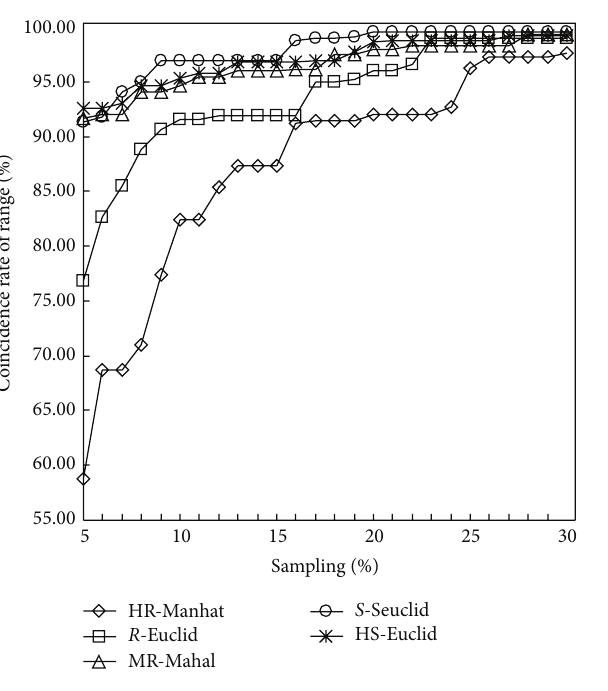
Figure 2: The coincidence rate of the range (CR) of subcore collec- tionsconstructedbyfivecombinationswiththesamplingpercentage increasing from 5% to 30%. HR-Manhat, high resistant group com- bining Manhattan distance; 𝑅 -Euclid, resistant group combining Euclidean distance; MR-Mahal, moderate resistant group combin- ing Mahalanobis distance; 𝑆 -Seuclid, susceptible group combining Standardized Euclidean distance; the HS-Euclid, high susceptible group combining Euclidean